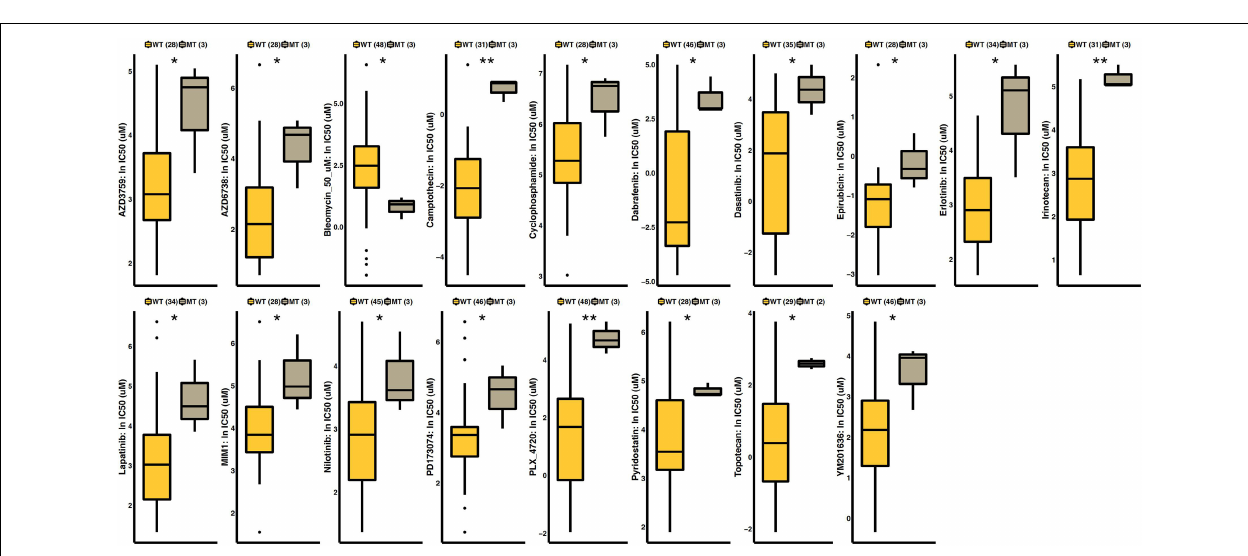
FIGURE 5 | Drug sensitivity analysis of GDSC-SKCM cell line data. SKCM cell lines with drug sensitivity data obtained from GDSC were grouped according to the FSIP2 mutation status, with yellow for the FSIP2-WT group and gray for the FSIP2-MT group. We used the Mann-Whitney U test to analyze the differences in the IC50 values of conventional chemotherapeutic drugs between the FSIP2-MT and FSIP2-WT groups, and the results with significant differences are marked with * (* p < 0.05; ** p < 0.01).